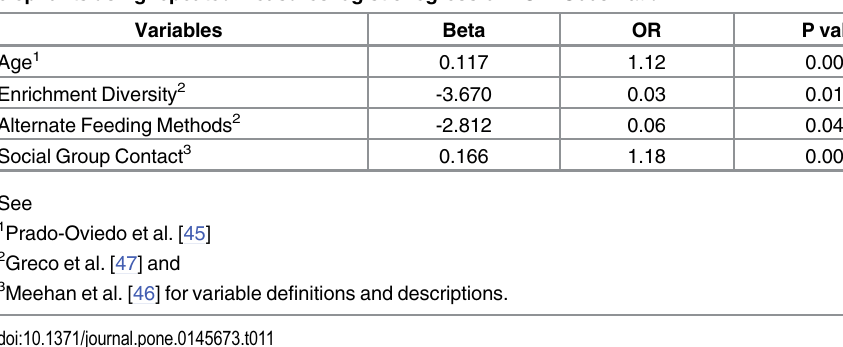
Table 11. Multi-variable assessment of hyperprolactinemia ( (cid:1) 18 ng/ml prolactin) in African female elephants using repeated measures logistic regression. OR: Odds